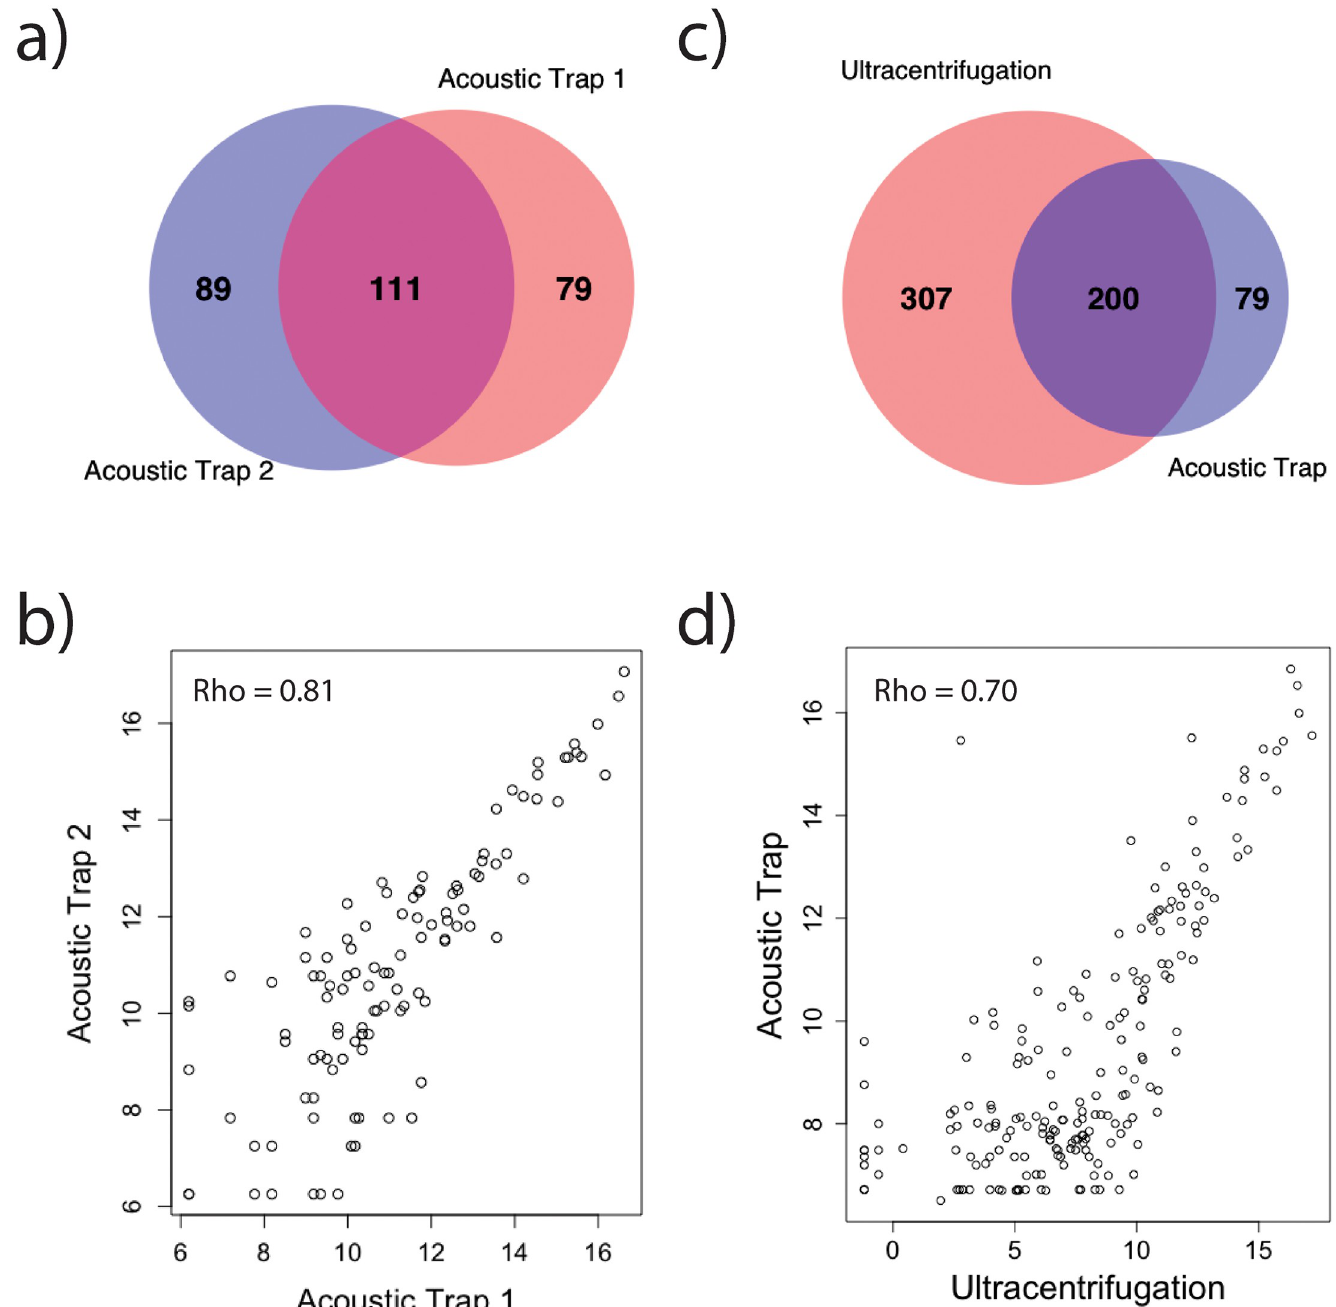
Fig 4. Comparison of the miRNA expression between samples. a) Venn diagram of common and exclusive miRNA found between the two replicates. Of the total of 279 miRNAs identified by the two replicates, 111 miRNAs are found in both libraries and 168 are exclusive to either of the libraries. b) Spearman correlation of the two replicates shows a significant correlation with rho = 0.81. c) Venn diagram of common and exclusive miRNA found between the acoustic trap and ultracentrifugation samples. Of the total of 586 miRNAs identified, 200 miRNAs are found in both libraries and 307 79 and 307 are found exclusively in the acoustic trap and ultracentrifugation samples respectively. d) Spearman correlation of the normalized miRNA expression of ultracentrifugation and median normalized expression of the acoustic trap replicates shows a significant correlation with rho = 0.70.